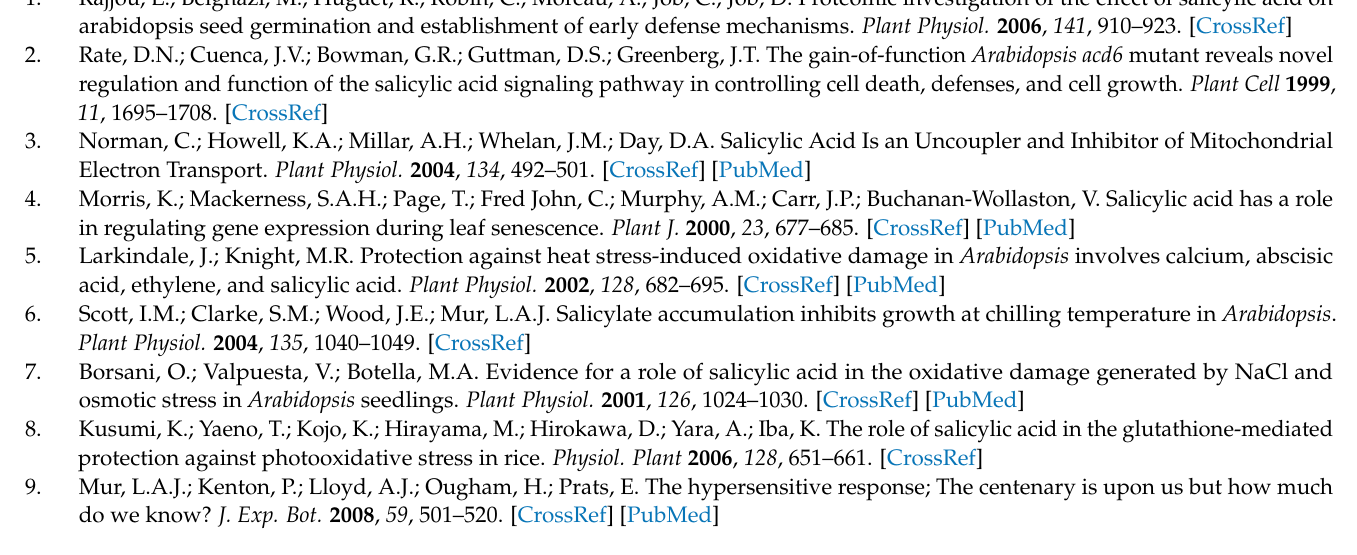
and 9, Figure S2: Tissue-specific expression of the UGT74 genes, Figure S3: Screening for the ugt74j1 mutants, Figure S4: Spikelet fertility of the ugt74j1 mutants, Table S1: Screening for defense genes using microarray, Table S2: Accession numbers of UDP-glucosyltransferases used in phylogenetic analysis, Table S3: Primers used in this